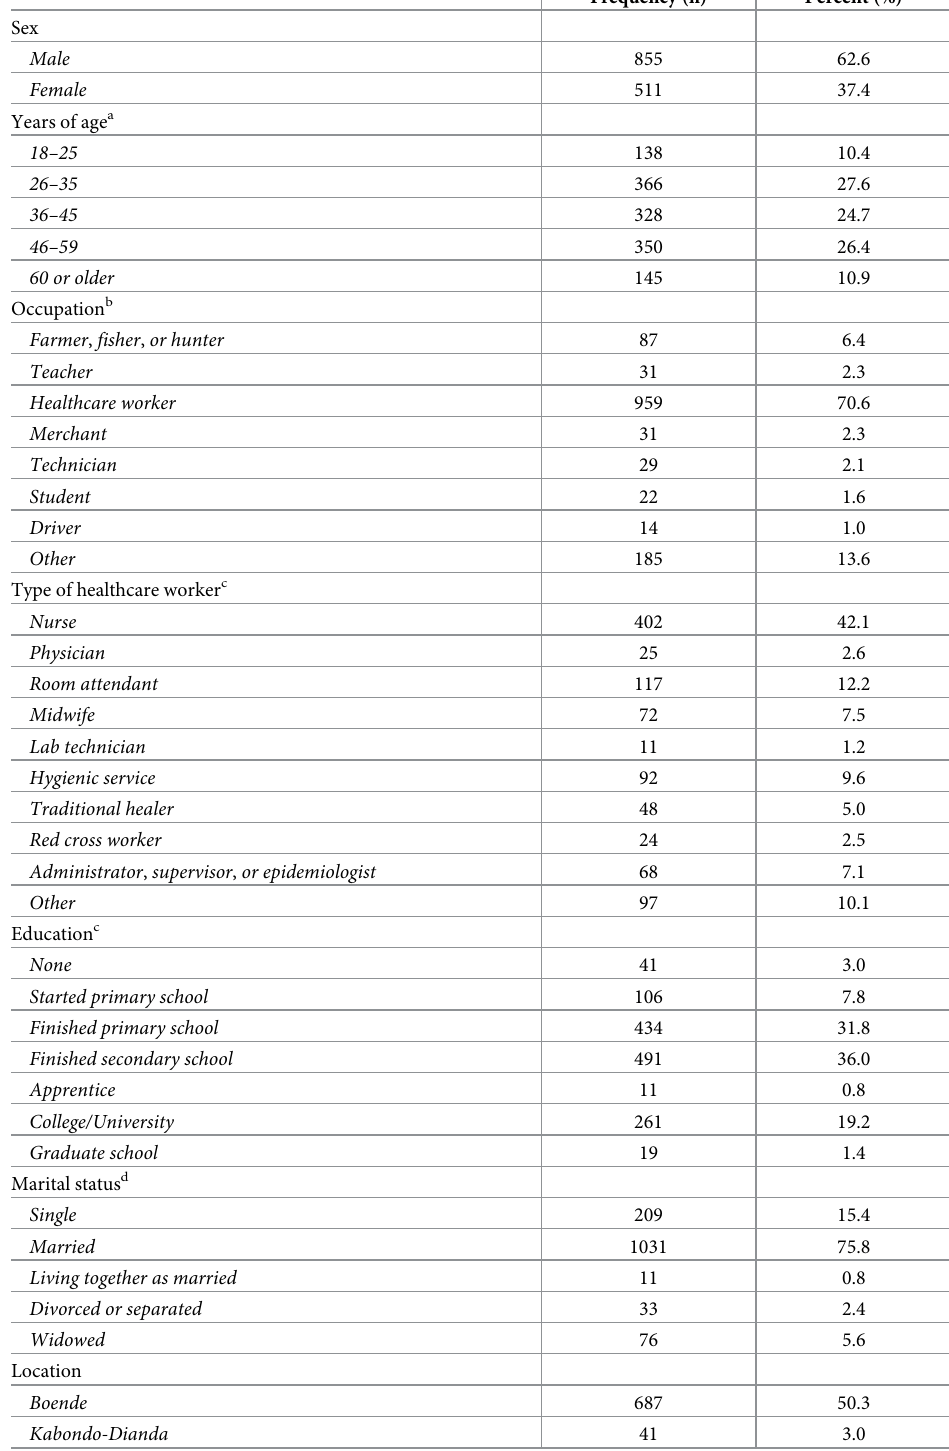
Table 1. Sample Characteristics among 1,366 individuals from Boende, Kabondo-Dianda, Yambuku, and Kikwit in the Democratic Republic of the Congo,